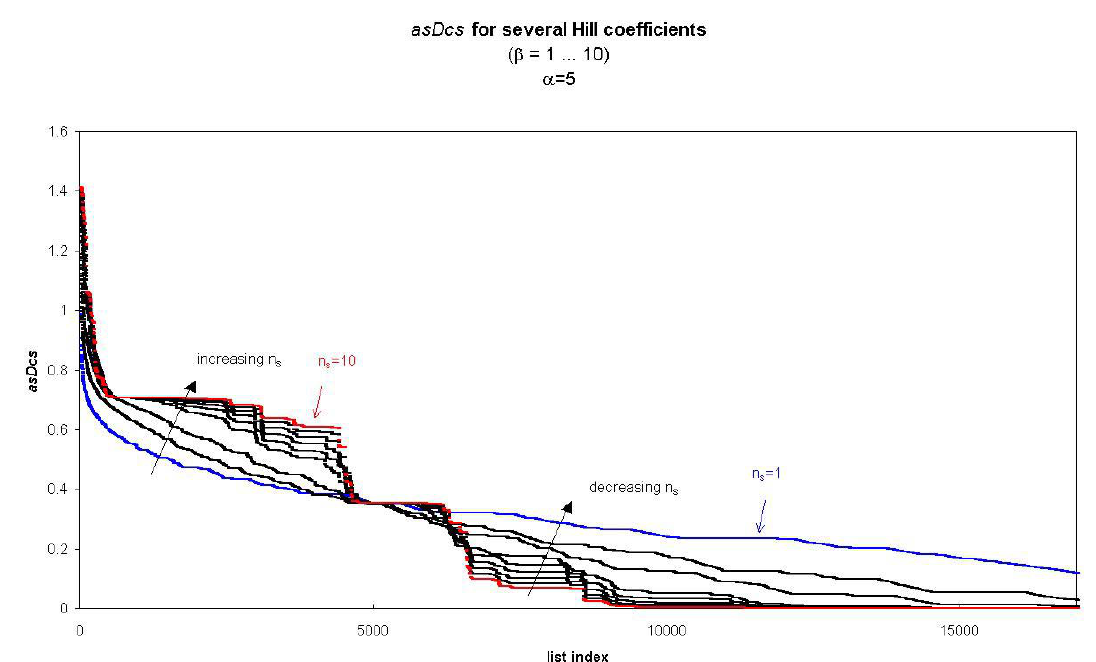
Fig.2: Illustration of the calculated distance measures asDcs for several Hill coefficients β (see arrows) for all 17,326 splice sites with an inverse ratio of adult to embryo ESTs for alternatively spliced ESTs compared to the ratio for normally spliced ESTs. asDcs was plotted over the list index of the sorted splice site lists. Every list for each Hill coefficient was sorted